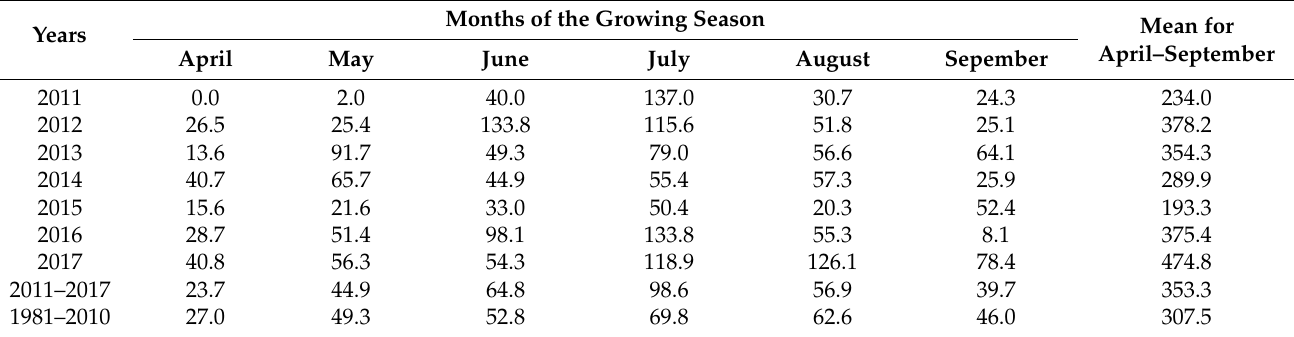
Table 2. Precipitation in the years 2011–2017